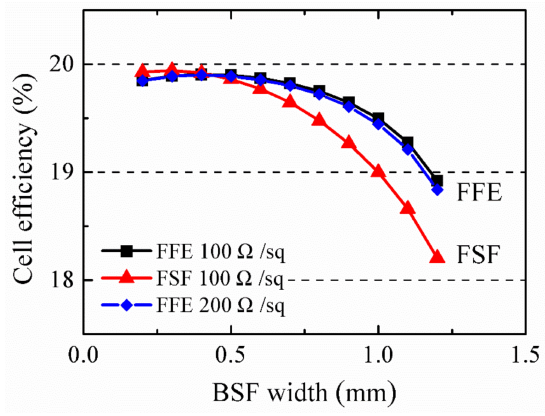
Figure 3. Efficiency of FFE IBC and FSF IBC cells with different BSF widths. Also shows the cell efficiency for different FFE sheet resistance